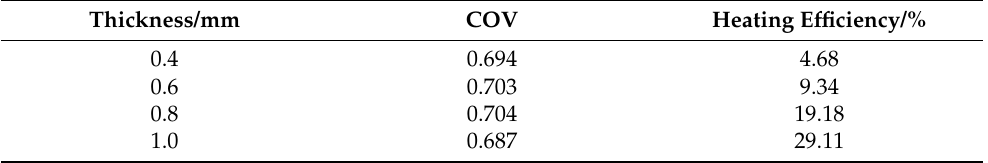
Table 4. The heating performance of different film thicknesses.